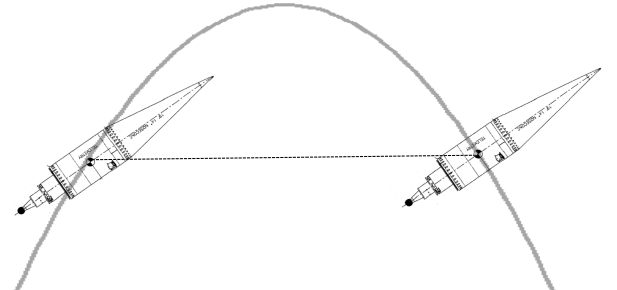
Figure 1. Orientation for payload 41.078 at 95km upleg and down- leg. The angle of attack (angle between roll axis and velocity vector) is critical for gas flow around instruments and plasma collection.